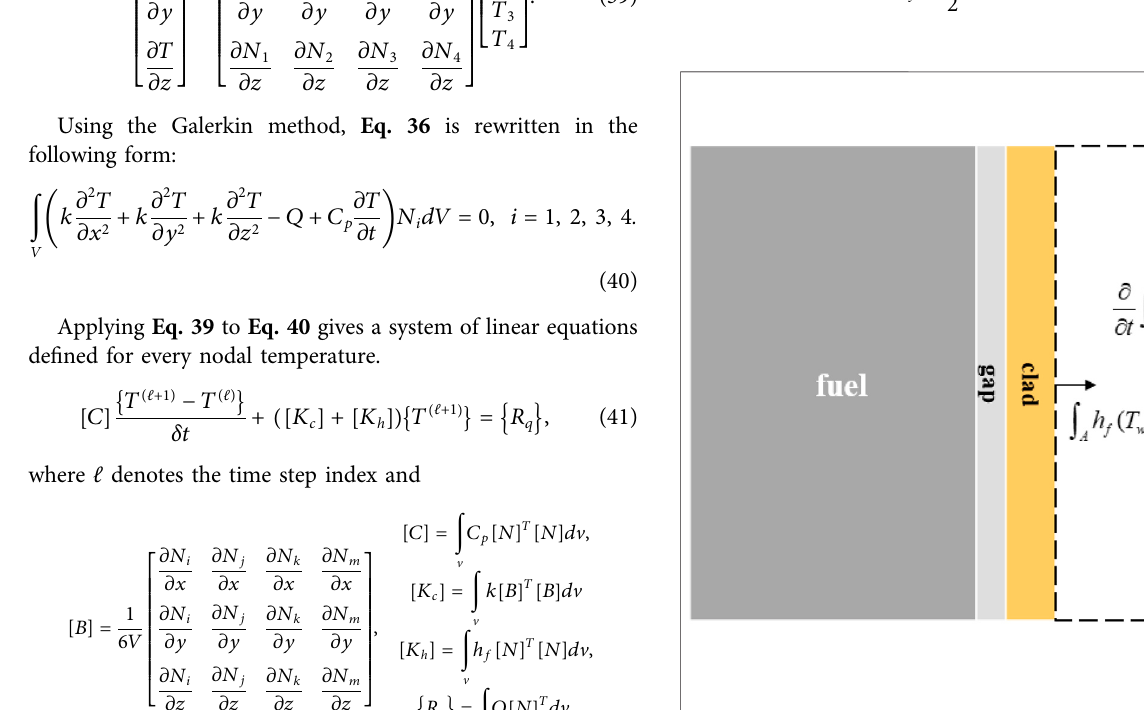
FIGURE 1 | A simpli fi ed lumped coolant